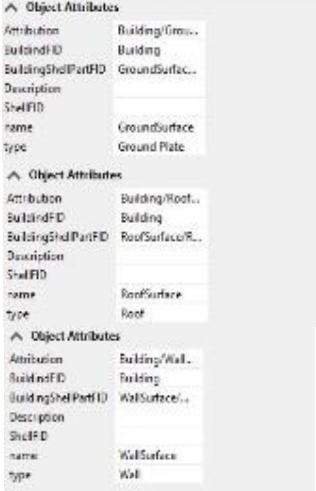
Figure 12: The attributes rendered to the ground, the roof and the wall surfaces After the extrusion of the model and the assignment of the required thematic and semantic information, the surfaces (the wall surfaces, the roof and the ground level) are exported in shapefile format.